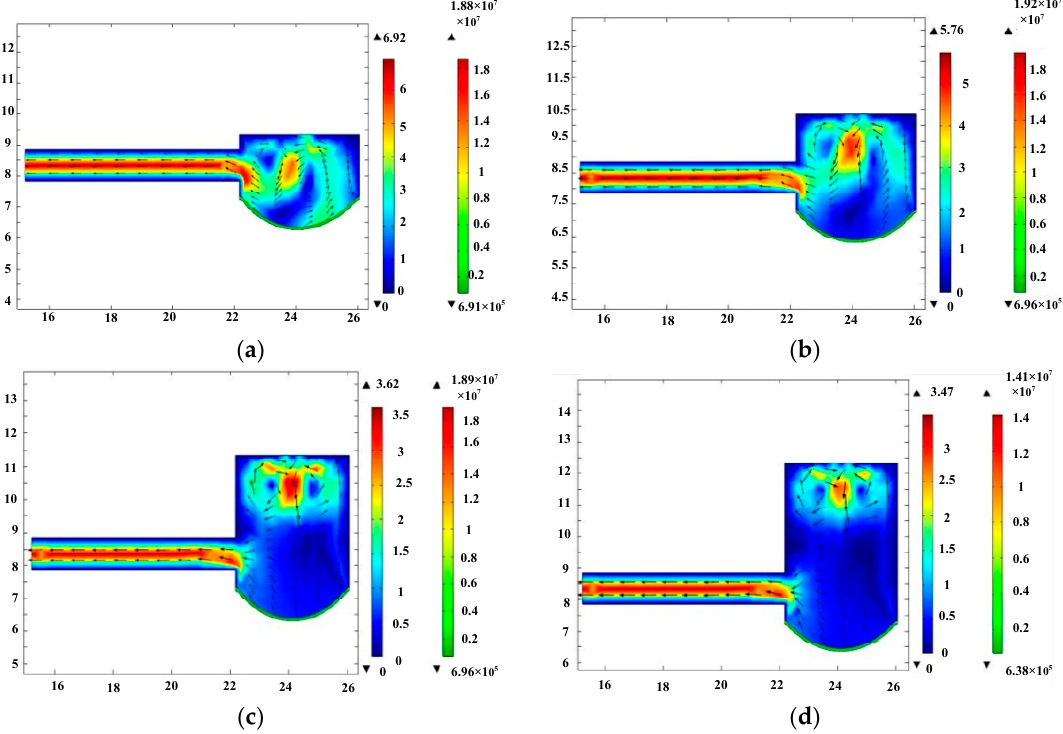
Figure 8. The simulation results of elastic outlet cavity. ( a ) Elastic outlet cavity with height of 2 mm, ( b ) elastic outlet cavity with height of 3 mm, ( c ) elastic outlet cavity with height of 4 mm, and ( d ) elastic outlet cavity with height of 5 mm. The metric for color bar: left color bar-m/s, right color bar-pa.